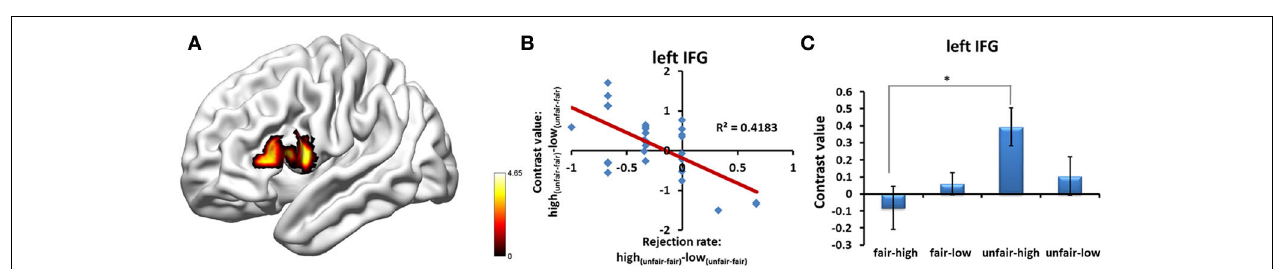
location, please see Table S3 in the Supplementary Materials. (D) Simple effects of the modulation of fairness by stake size in insular subregions. Abbreviations: aINS, anterior insula; pINS, posterior insula. ∗ p < 0 . 05, ∗∗ p < 0 . 01, ∗∗∗ p < 0 . 001. Error bars indicate standard errors of the mean.